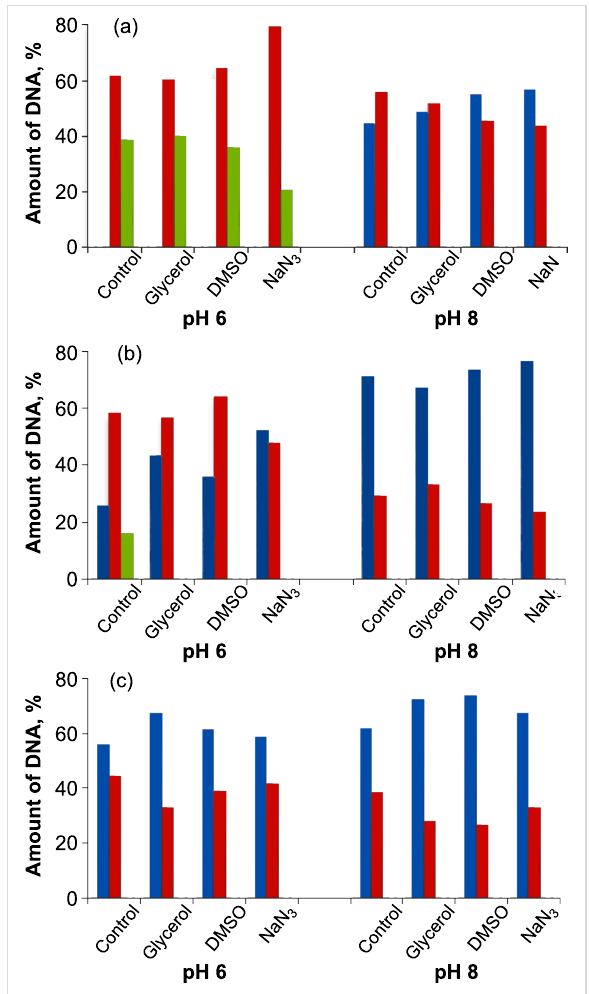
Figure 8: Effect of hydroxyl radical/singlet oxygen scavengers (20 mM) on the efficiency of DNA cleavage at pH 6 and 8 by 15 μ M of conjugates 1 (a), 6 (b), and 7 (c) after 10 min of irradiation. Color coding: Blue: Form I (supercoiled) DNA; red: Form II (relaxed) DNA; green: Form III (linear)